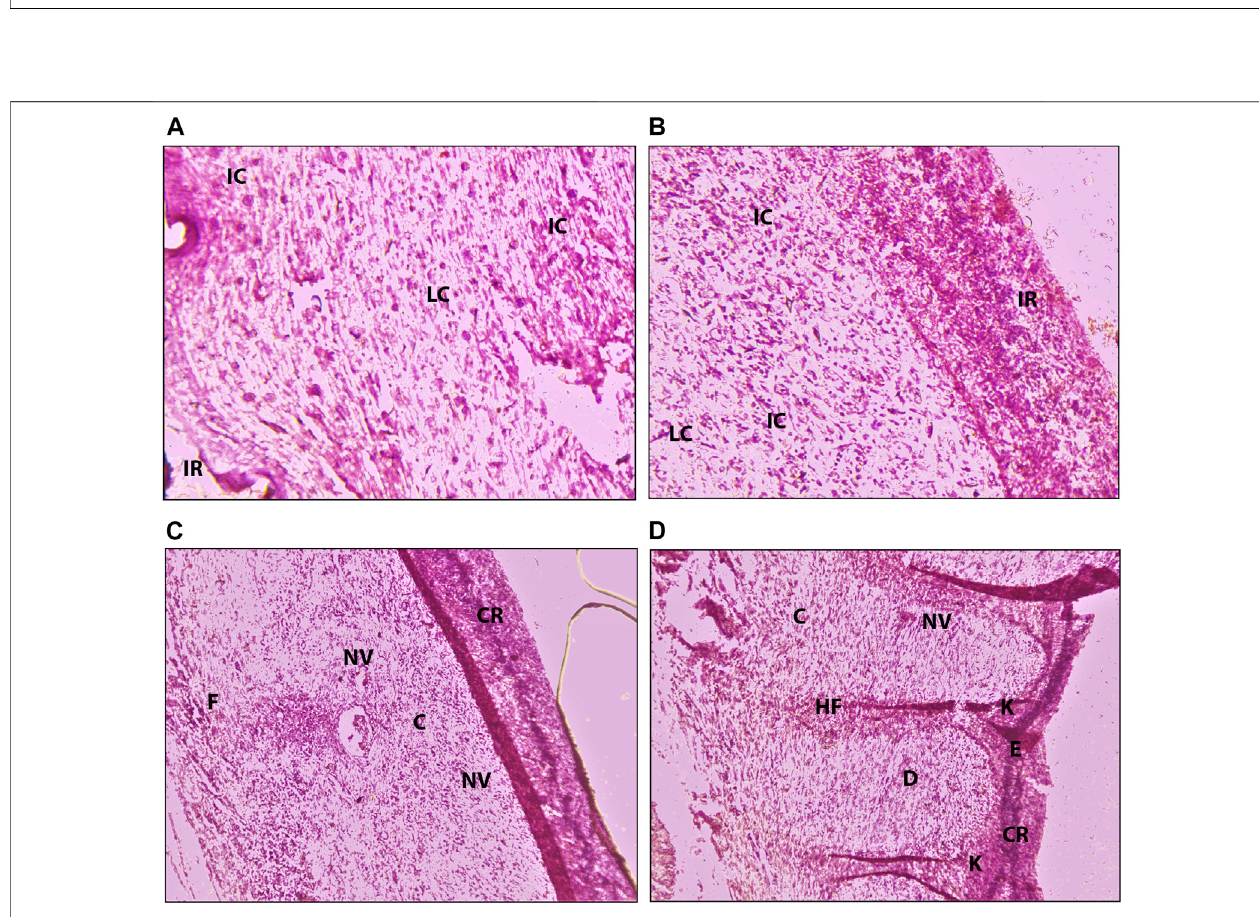
FIGURE 7 | Photomicrograph (200X) of hematoxylin-eosin stained histological dermal section of wound area for (a) control group, (b) FeBL group, (c) standard group, and (d) FeTP group. C-collagen, CR-complete re-epithelialization, D-Dermis, DE-Disrupted epidermis, F- fi broblast, HF-hair follicle, IC-In fl ammatory cells, IR- Incomplete re-epithelialization, K-keratinocytes, LC-Less amount of collagen, NV-neovascularization, PC-pus cells, SE-Separation of epidermis from dermis.